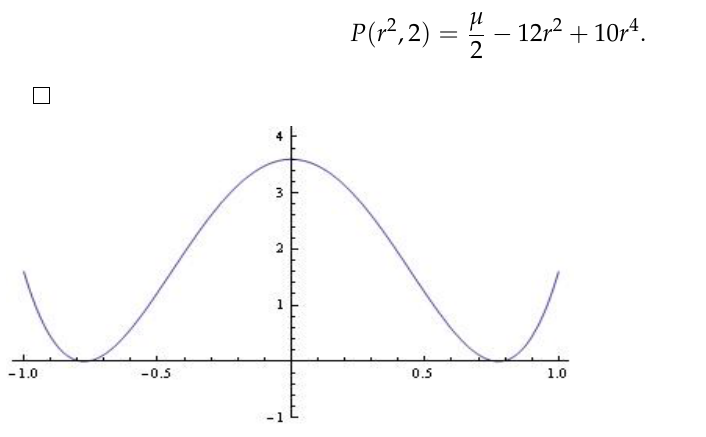
Figure 6. P ( r 2 ,2 ) for n = 5 and µ = 7.2.